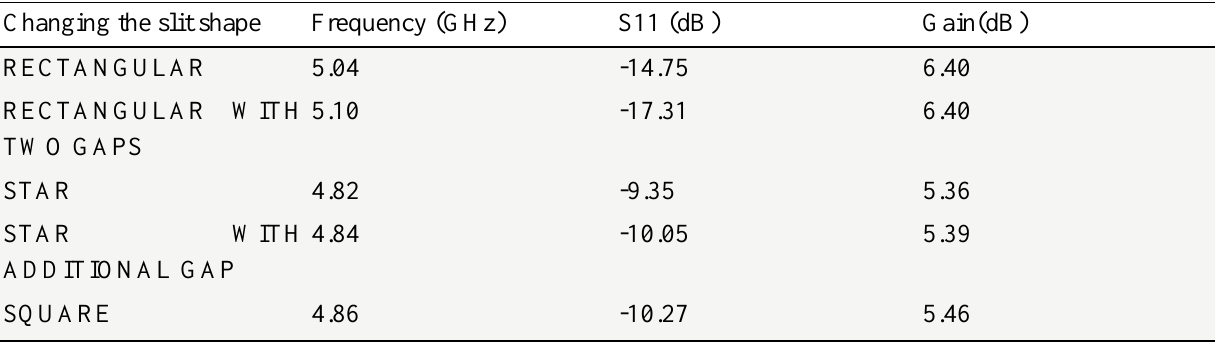
Table 6. Design changes on frequency range 1 to